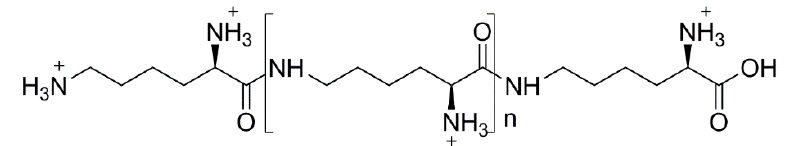
Figure 3. Structure of ε -PL at pH < pI.